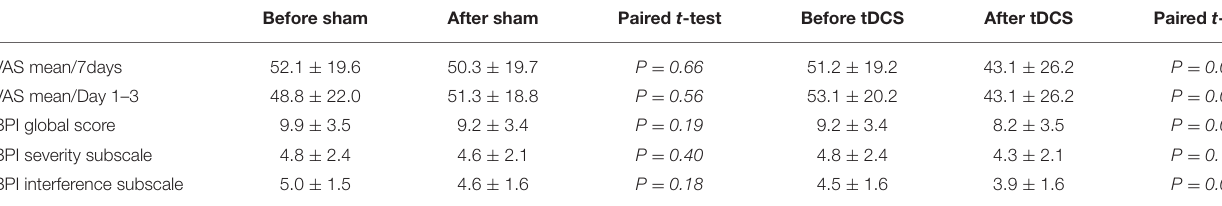
TABLE 2 | VAS and BPI scores (Mean ± SD) before and after sham and active tDCS. Before sham After sham Paired t -test Before tDCS After tDCS Paired t -test